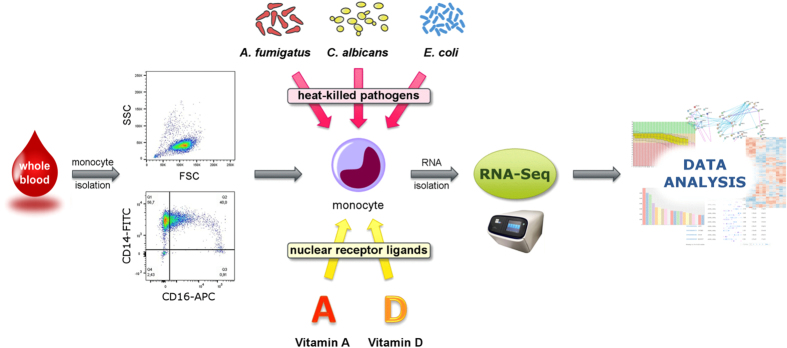
Experimental workflow.Human monocytes were isolated from fresh whole blood and purity of the cells was analyzed by flow cytometry. Upper scatterplot: Forward scatter (FSC) and side scatter (SSC) measurement. Lower scatterplot: Fluorescence intensities of cells stained with FITC-conjugated CD14 antibody and APC-conjugated CD16 antibody. Monocytes were then pre-incubated with vitamin A (atRA) or vitamin D, followed by stimulation with heat-killed A. fumigatus, C. albicans or E. coli for 6 h. Poly-(A) RNA was isolated from the monocytes and subjected to RNA sequencing.